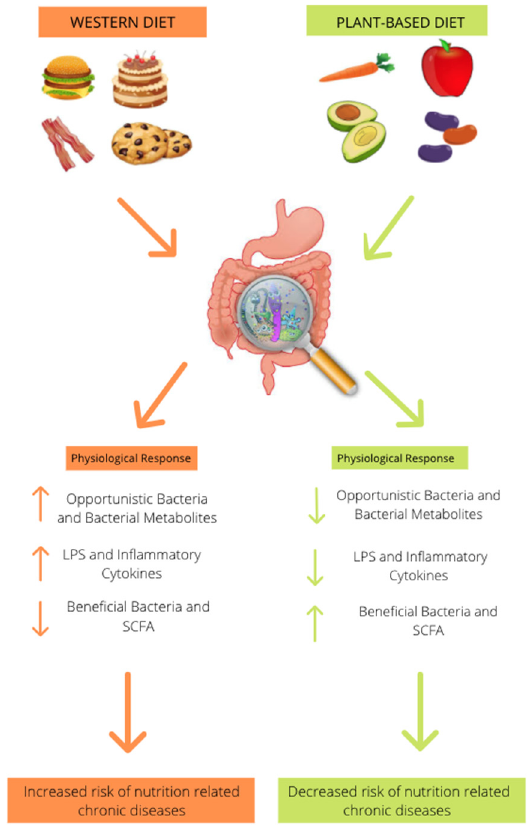
Figure 1. A traditional “Western diet” that is high in fat, high in processed sugar, and low in fiber results in an increase in Firmicutes, Proteobacteria, Mollicutes, Bacteroides spp., Alistipes spp., and Bilophila spp., Enterobacteriaceae, Escherichia , Klebsiella , and Shigella while decreasing the beneficial bacteria Bacteroidetes , Prevotella , Lactobacillus spp., Roseburia spp., E. Rectale , Bacillus bifidus and Enterococcus resulting in a reduction in SCFA production. It also increases LPS, TMAO, and inflammatory cytokines increasing risk for nutrition-related chronic diseases, obesity, and type II diabetes. Adherence to a plant-based diet that is rich in whole grains, fruits, and vegetables had inverse effects on the bacterial composition. It reduced opportunistic bacteria resulting in a reduction in LPS, TMAO, and inflammatory cytokines. It also increased the production of SCFAs, reducing inflammation and risk for obesity and type II diabetes.